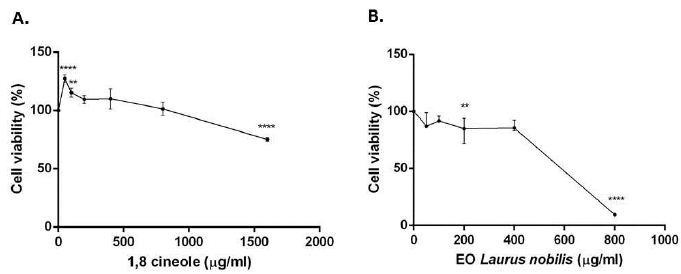
Figure 1. Cell viability calculated as percentage after MTT assay. Cells were treated with different concentrations (1600–50 µg/mL) of 1,8-cineole ( A ) and L. nobilis essential oil ( B ), for 24 h and solvent (DMSO, 0.1%) alone. Data are the mean ± SD of three experiments ** p < 0.01, **** p < 0.0001 vs. DMSO.